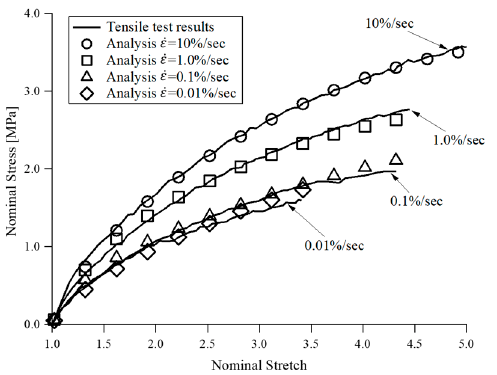
Figure 1. Tensile loading test results of thermoplastic elastomer (TPE).